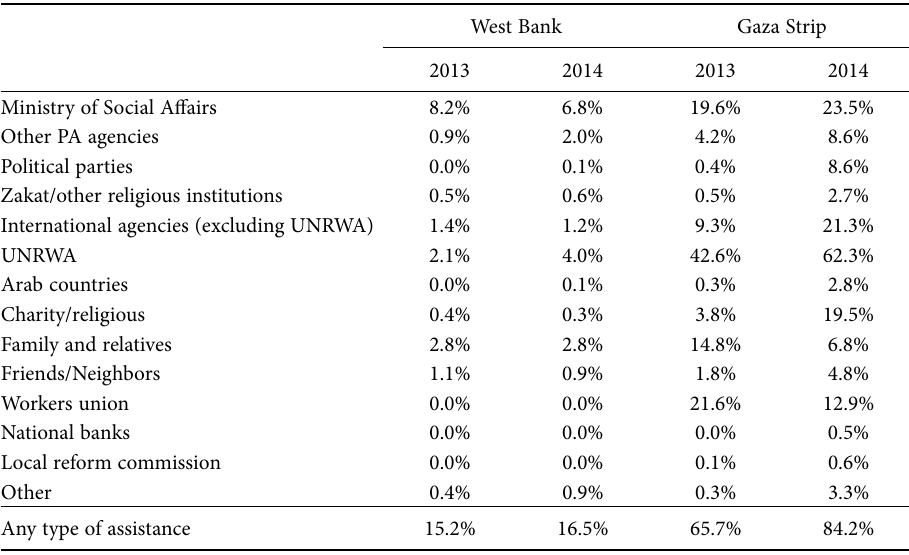
Table 4. Reported sources of assistance by Region a